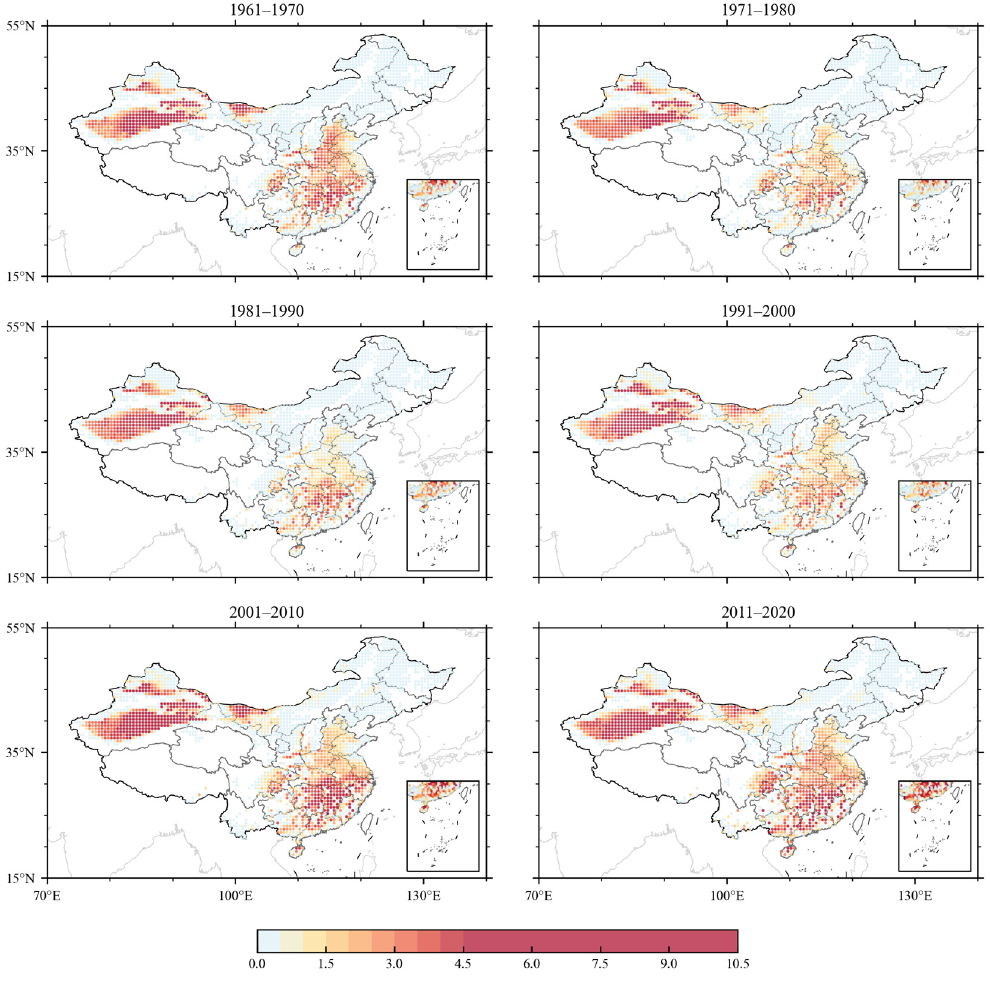
Figure 3. Distribution diagram of the average frequency of heat waves in each decade based on the absolute method.